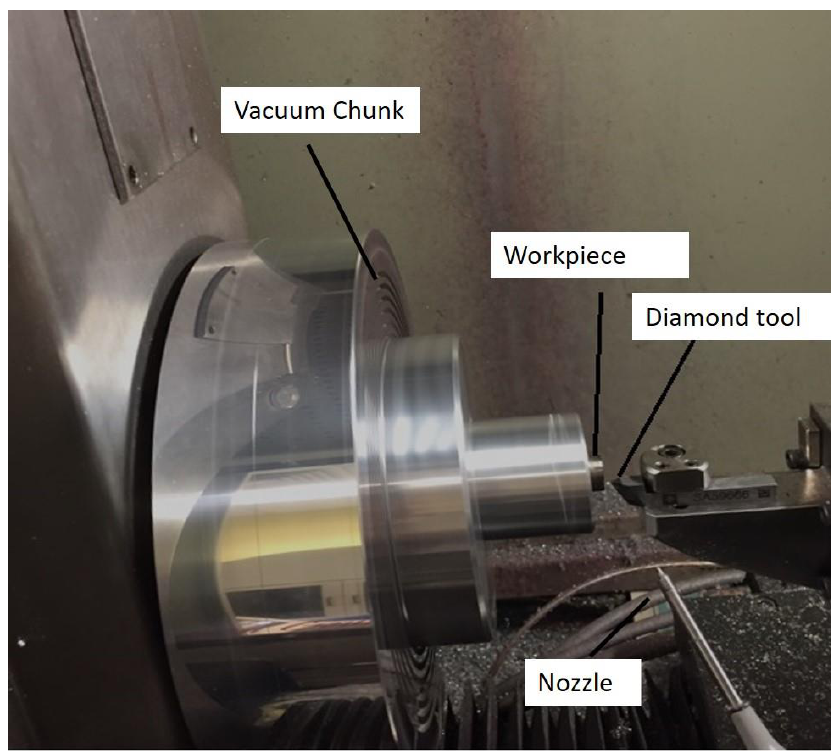
Figure 1. The experimental setup of single point diamond turning (SPDT) of titanium alloys.